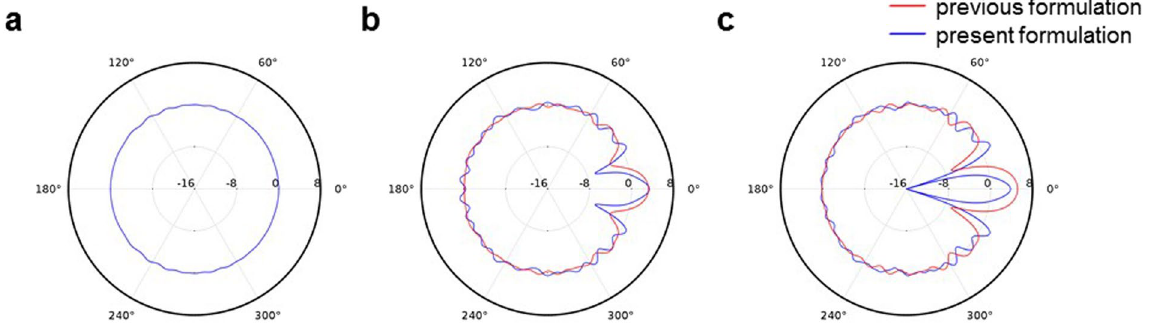
Figure 3. The scattering patterns of sound scattering around acoustic cloaks. ( a ) Polar plot of directivity pattern of the existing cloak 1 in stationary medium. ( b ) and ( c ) Polar plots of directivity patterns of the convective cloaks 7 in moving media for M = 0.1 and M = 0.2, respectively. The directivity patterns are calculated in dB scale by using equation (5) at r = 10 R 1 . The incident angles and the Helmholtz numbers are set as α = 0 and kR 1 = 3. A large deviation from 0 dB in directivity plot indicates that we have more scattering unwanted. In ( b ) and ( c ), the blue lines indicate the results of the present formulation using equation (2), and the red lines indicate the results of the previous formulation 7 using equation (1). There is a clear difference between the scattering patterns of the previous and present formulations, and the difference becomes larger as the Mach number